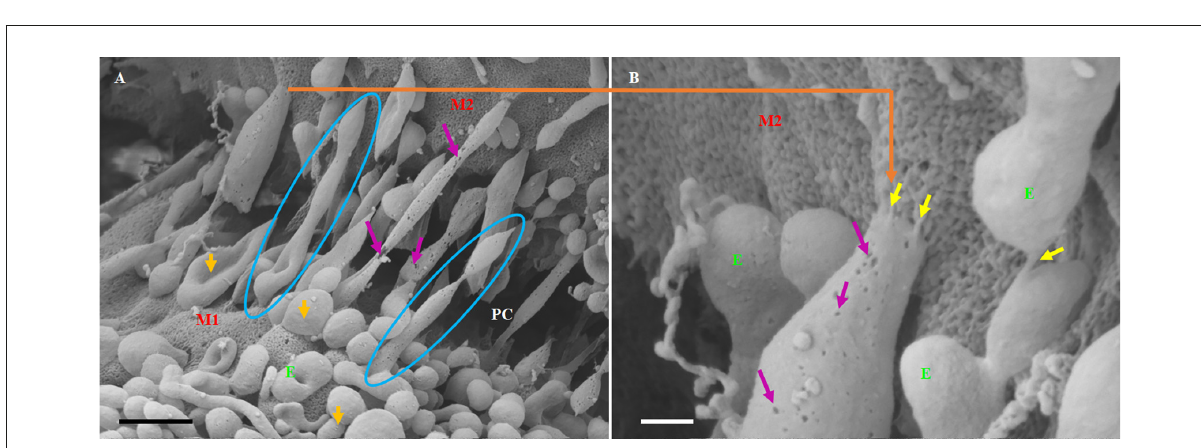
FIGURE7 Theformationoflong-slenderTUNTsisinducedbythefusingofmultipleTF-exosomesattheirellipticalends. (A) IllustratesTF-exosomesaccrued to the BEC cell membrane and progressing into oblong-shaped, hollow tubes. Scale bar = 1,000 nm. (B) An enlarged area from “A” demonstrating theinteractionoftheTUNT“sticky”endswiththeBECmembrane.Scalebar=200nm.EdenotesTF-exosomesandM1andM2denotetheporous membranes on which TUNTs originate (M1) and the target cell membrane (M2). PC denotes the paracellular space between M1 and M2. The blue circles indicate TUNT formation. The purple arrows indicate the pores on the TF-exosomal-induced TUNTs. The yellow arrows indicate the interaction between the distal extremities of TUNTs and the BEC membrane (Mentor and Fisher, 2021).